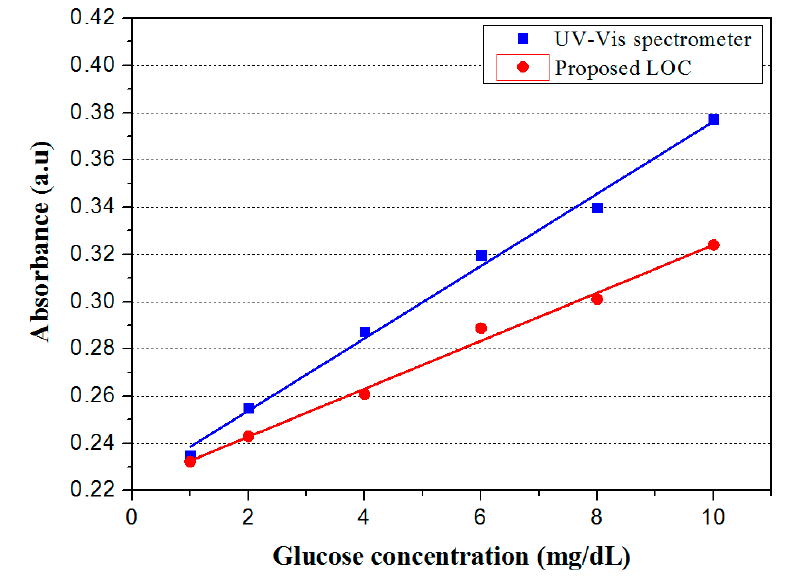
Figure 13. Measured absorbance of proposed LOC and UV-Vis spectrometer as a function of glucose concentration.